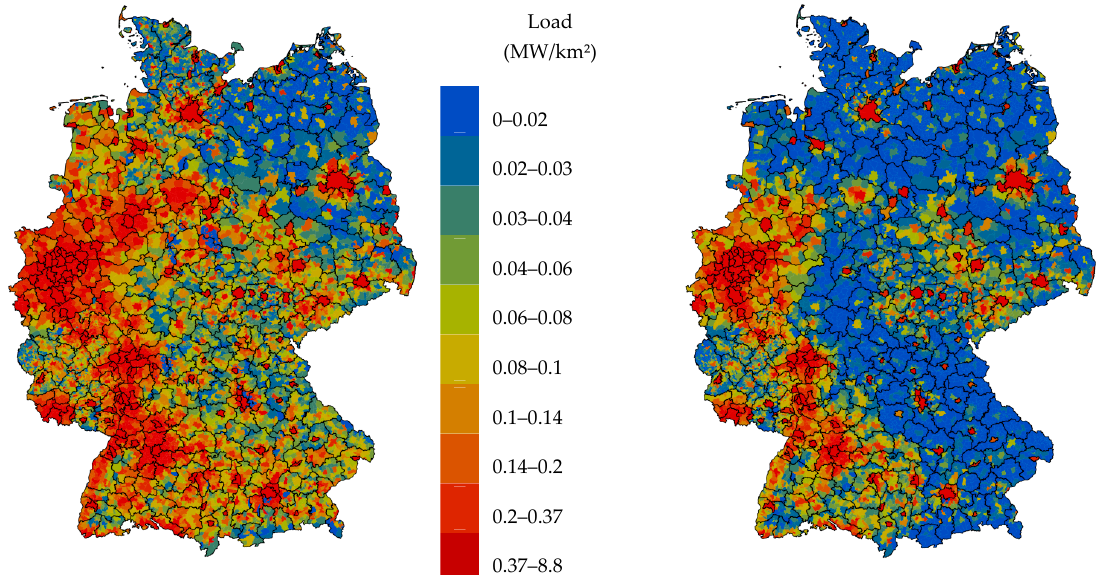
Figure 7. Electrical load with the adjusted load factors and the additional steady load; ( left ) highest load (5 December 2013, 18:00); ( right ) lowest load (2 June 2013, 07:00) [59].